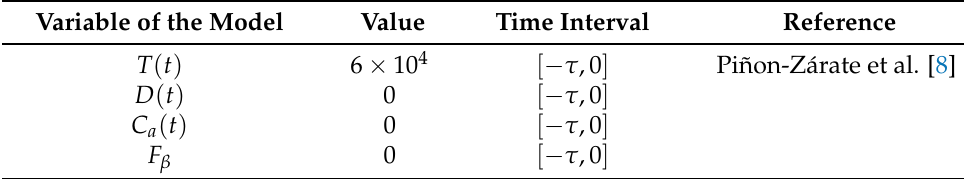
Table A1. Initial condition of the